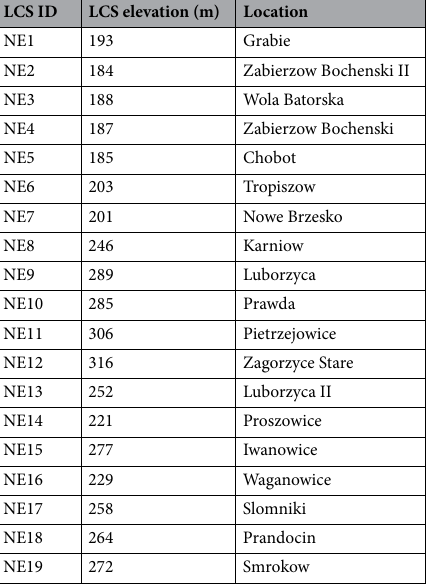
Table 4. Sensor location and elevation in the north-east section (outside the urban areas of Krakow).